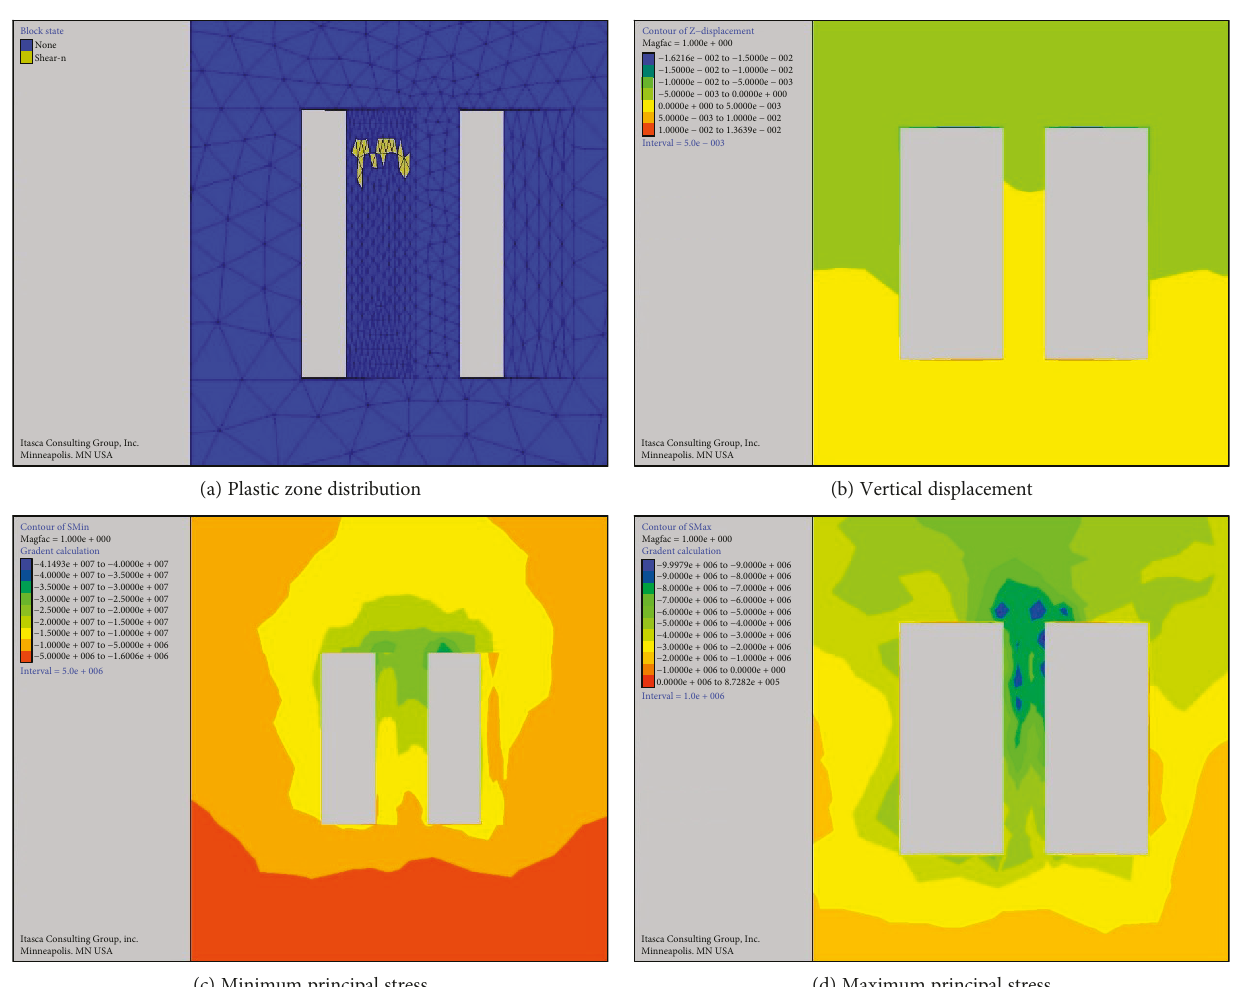
Figure 14: Scheme 2 mining